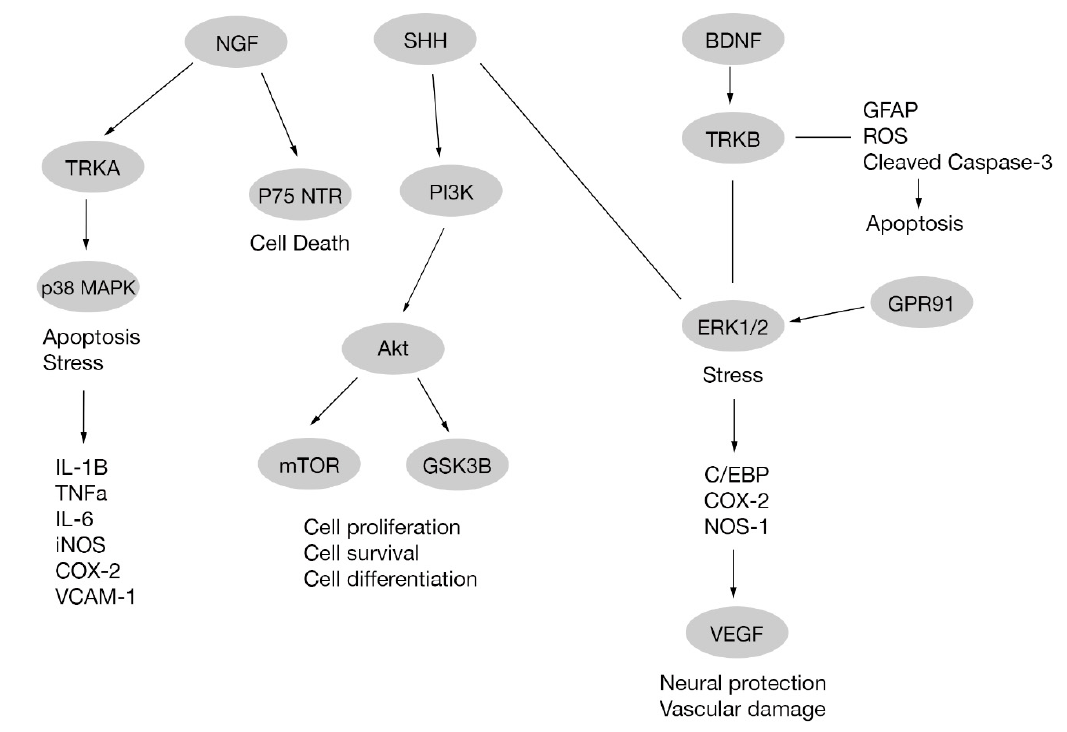
Figure 1. Pathways scheme for neurotrophic factors, mitogen-activated protein kinase cascades and protein kinase B in retinal ganglion cells (RGC) cells.